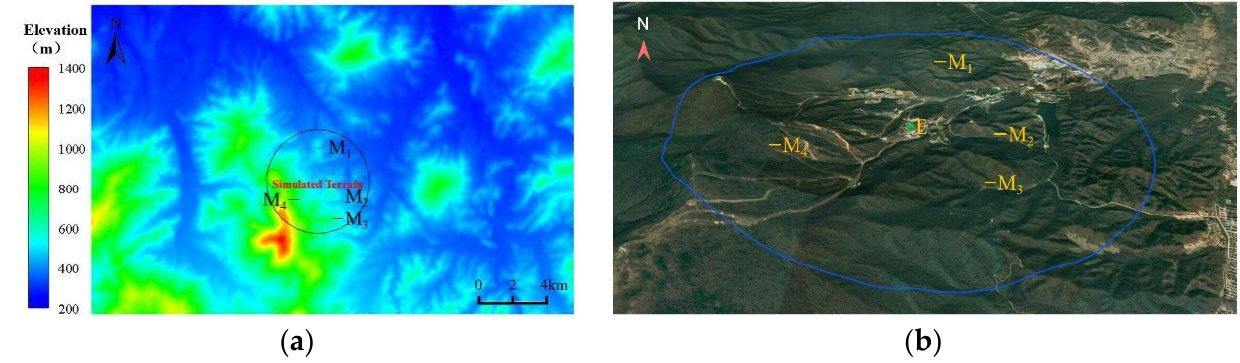
Figure 9. Elevation map and terrain image of the study area. ( a ) Elevation map ( b ) Terrain image.